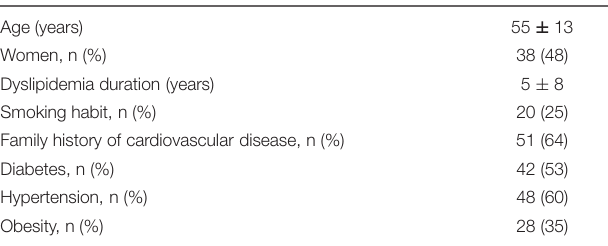
TABLE 1 | Baseline characteristics of all subjects ( n =